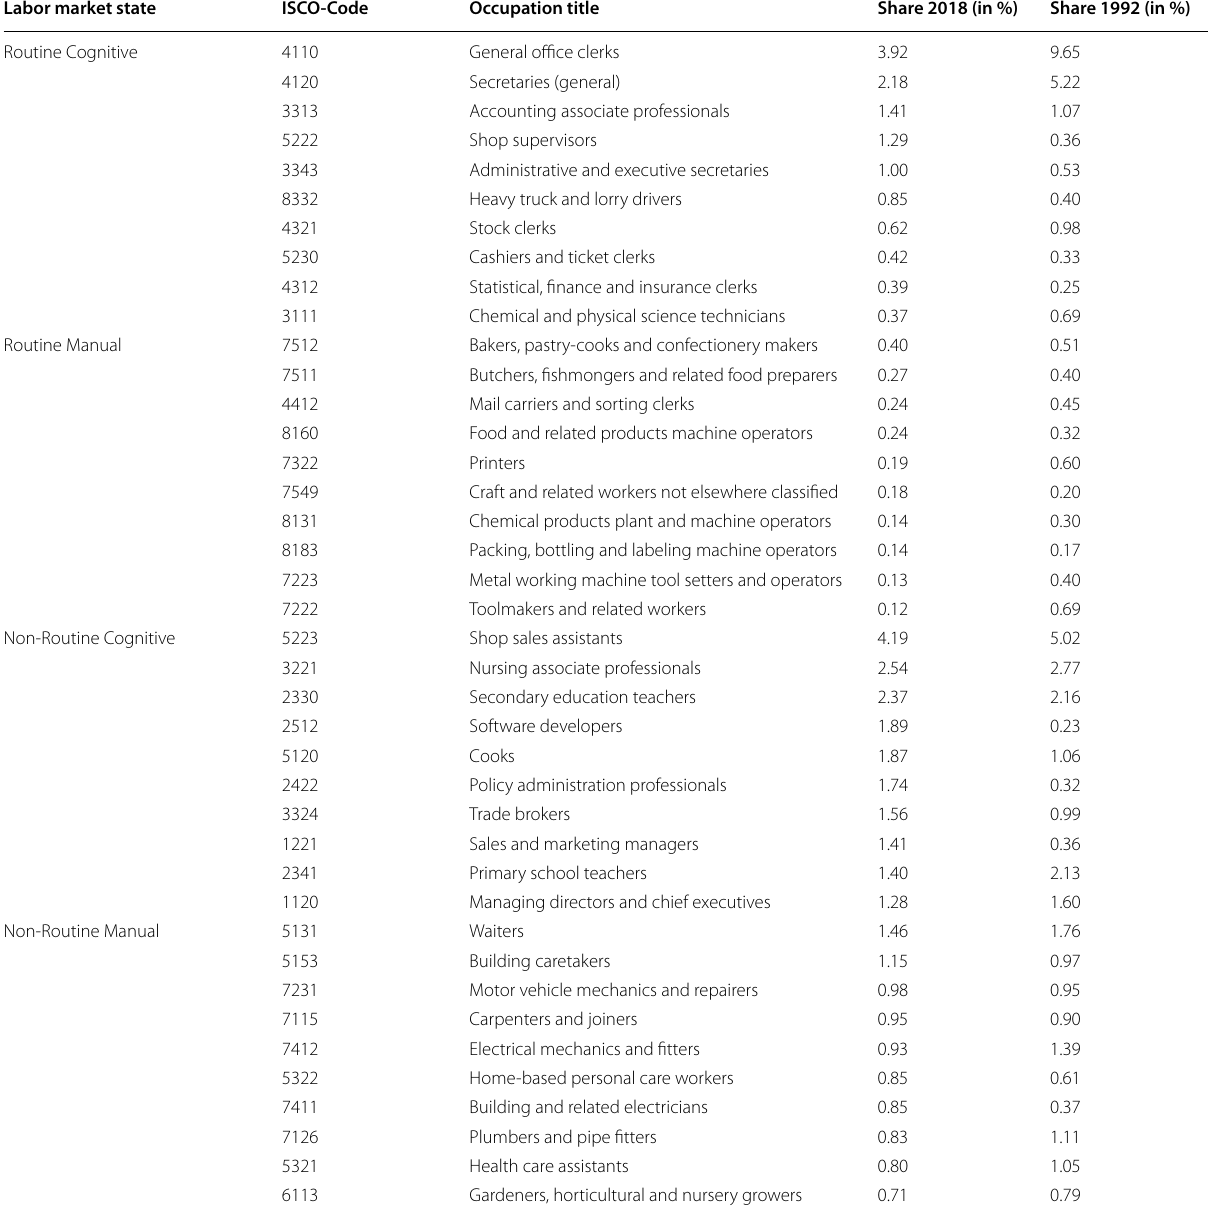
Shares of employed workers in the respective years.